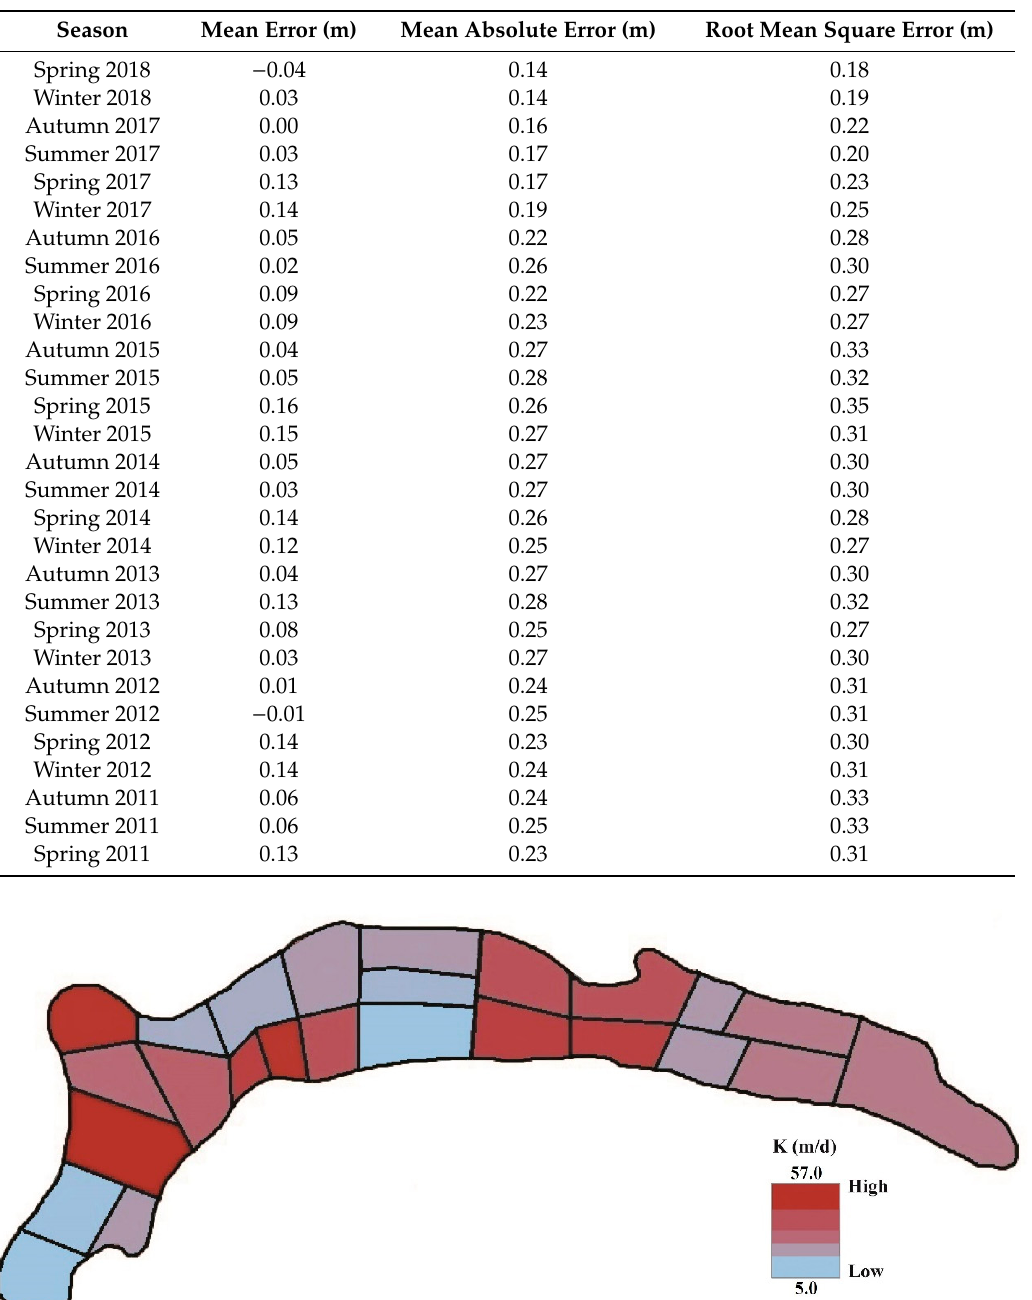
Table 2. Semi-transient calibration of Birjand groundwater model.